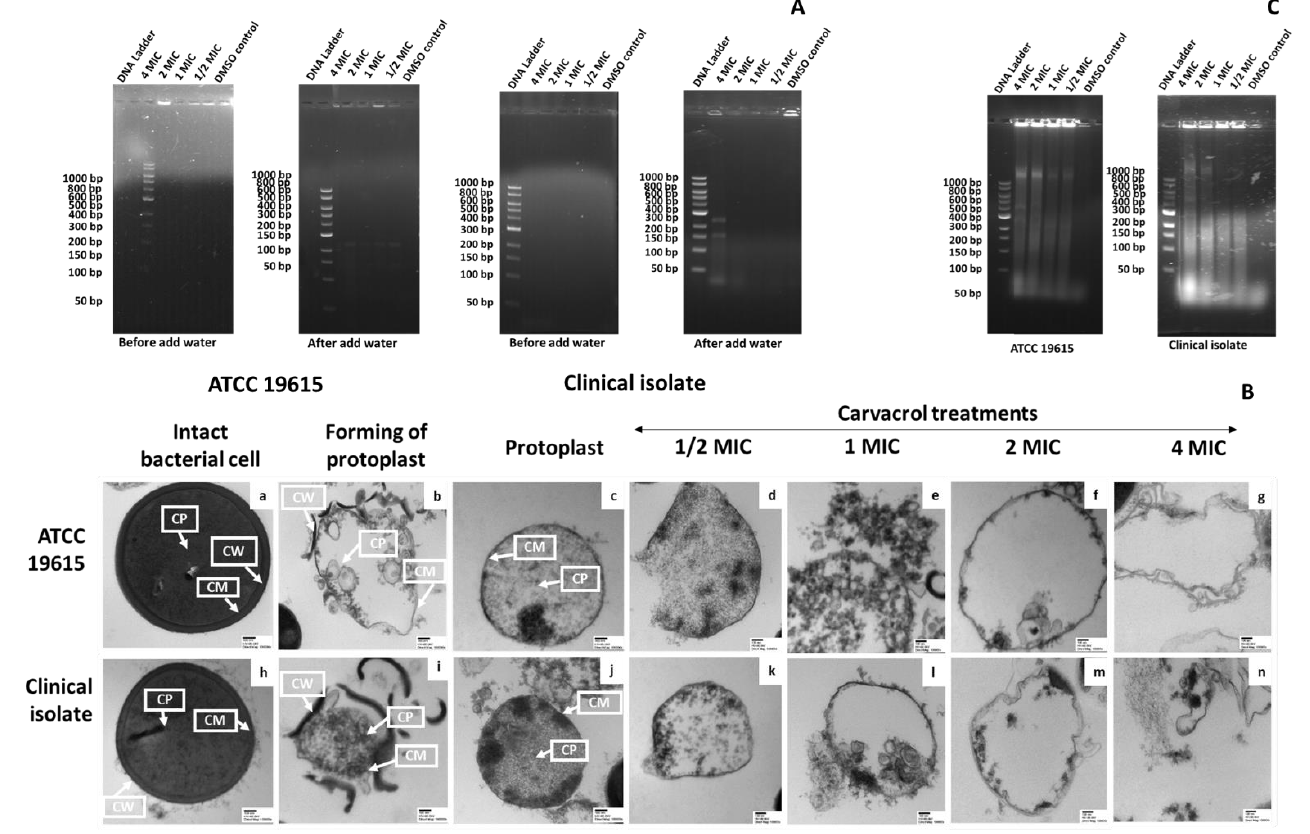
Figure 4. Confirmation of Streptococcus pyogenes protoplast formation, carvacrol effect on membrane damage of S. pyogenes protoplast, and cytoplasmic nucleic acid leakage. ( A ) Agarose gel (0.8%, w / v ) electrophoresis and gel red staining of centrifuged clinical isolate-protoplast pellets after formation and busting out by adding water. ( B ) Transmission electron micrographs of thin sections of intact bacteria without treatment (a,h), a representative example of a progressive stage of protoplast of the effect of mutanolysin in protoplast buffer (15 min at 37 ◦ C) (b,i), protoplast resulting from exposure in protoplast buffer with mutanolysin (30 min at 37 ◦ C), and ATCC 19615 and clinical isolate protoplast cell suspensions (OD 600 = 0.6) treated with DMSO (c,j) or 1/2 × MIC (d,k), 1 × MIC (e,l), 2 × MIC (f,m), and 4 × MIC (g,n) of carvacrol concentrations for 2 h at 37 ◦ C. Magnifications and bars: × 50,000 (200 nm) and × 100,000 (100 nm). CW: Cell wall; CM: Cytoplasmic membrane; CP: Cytoplasm. ( C ) Agarose gel (0.8%, w / v ) electrophoresis, gel red staining of ATCC 19615, and clinical isolate-protoplast supernatants after exposure to the different carvacrol concentrations; 1 kb ladder as